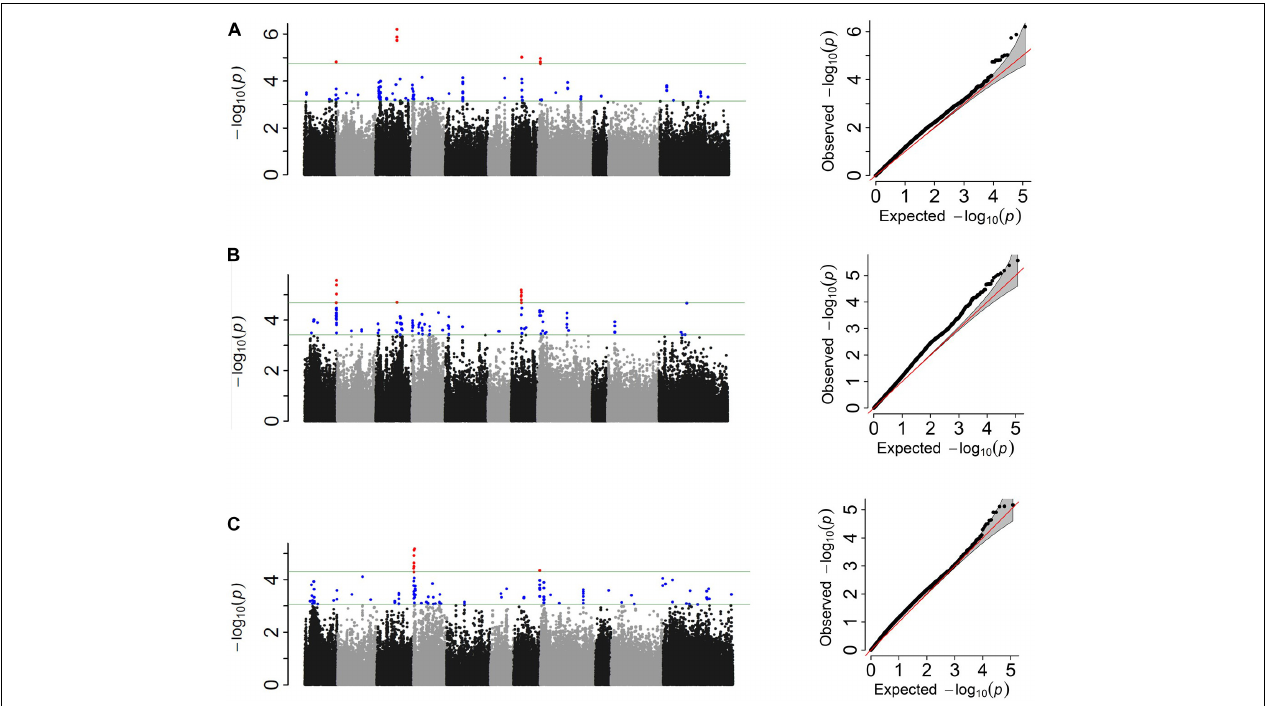
FIGURE 4 | Manhattan and corresponding Q–Q plots representing the genetic architecture of Fusarium solani resistance from GWAS analyses using (A) quantitative, (B) three-class, and (C) binary scoring systems in Middle American Diversity Panel (MDP). TABLE 5 | Significant genomic regions/SNPs from GWAS in Middle American Diversity Panel ( P < 0.01). Phenotypic data Interval Peak SNP R square Cumulative R square Chrom Genomic interval (Mb) Position